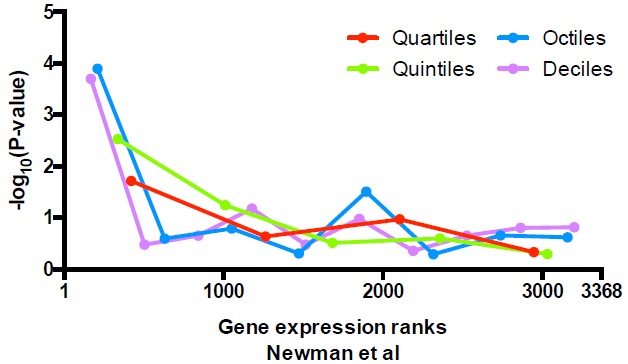
Significance of the enrichment in uniquely positioned nucleosomes among genes stratified by expression level determined in Newman et al.